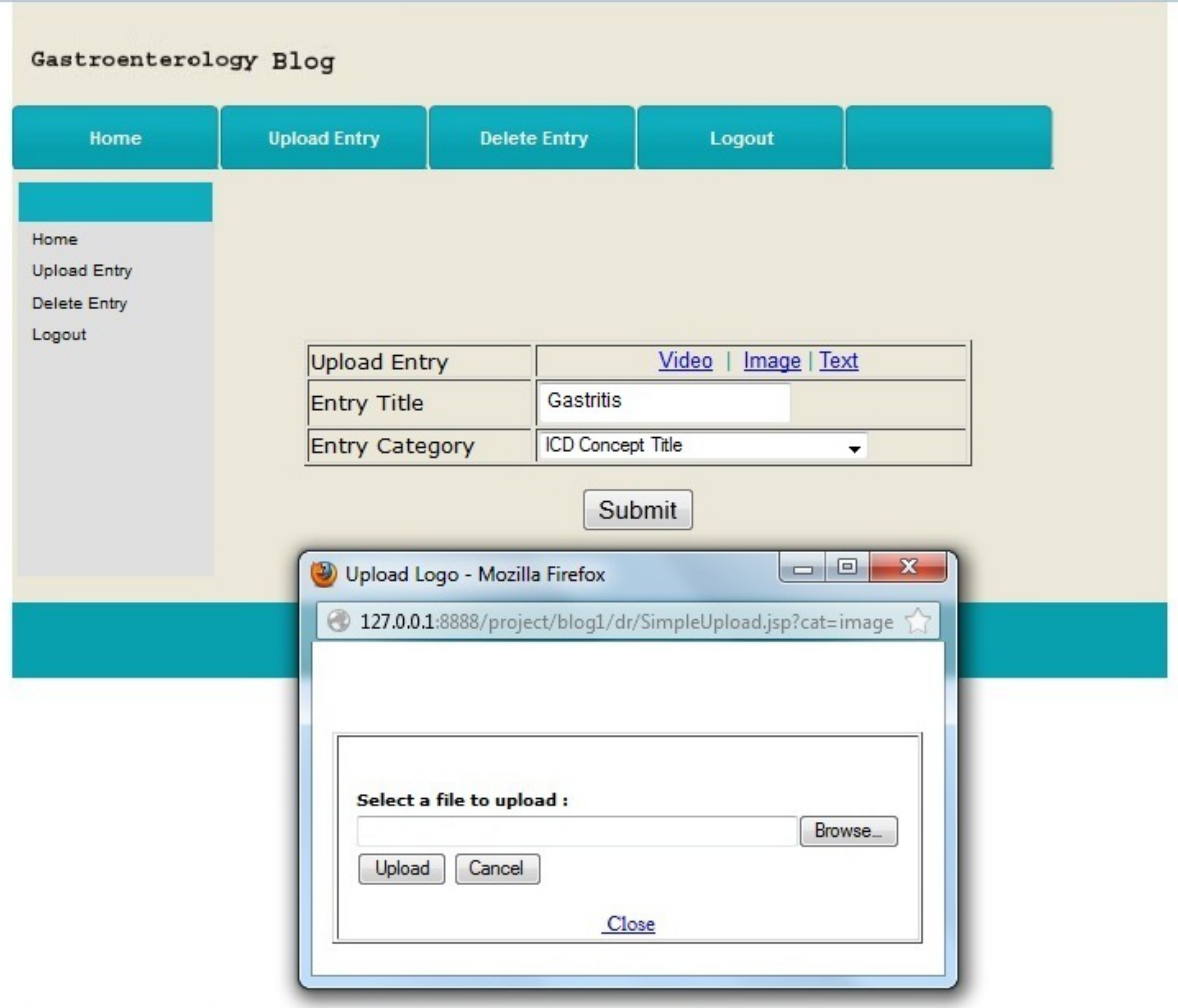
Figure 6. An example of the uploading mode system